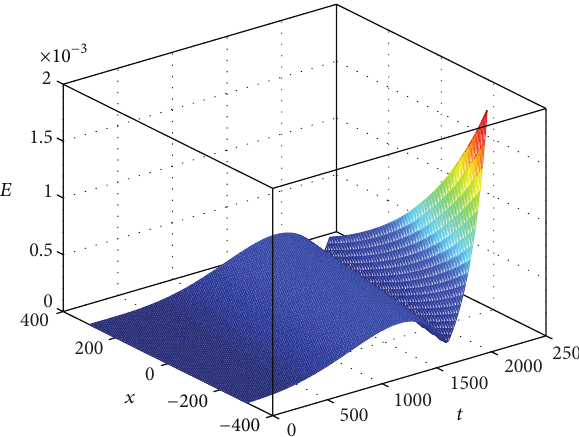
Figure 7: Absolute error of generalized Burgers-Fisher-type equa- tion, (24), with 𝛿 = 1 , 𝛾 = 0.01 , and ] = 0.01 .